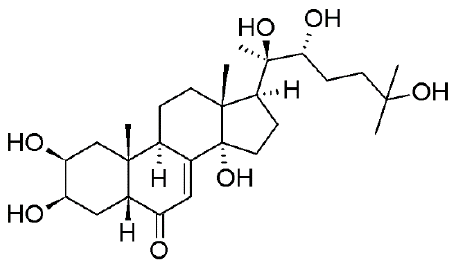
Figure 1. Chemical structure of 20-hydroxyecdysone (ecdysterone, 20-E).